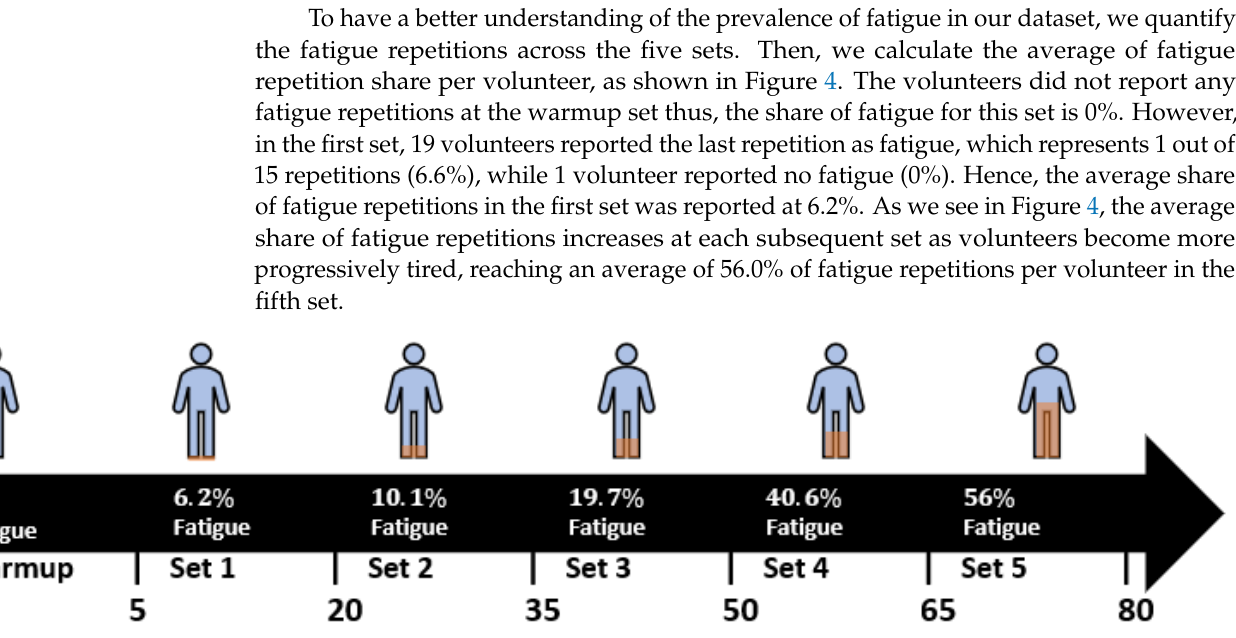
Figure 4. A visualization of the weighted average of fatigue shares per exercise sets in the collected